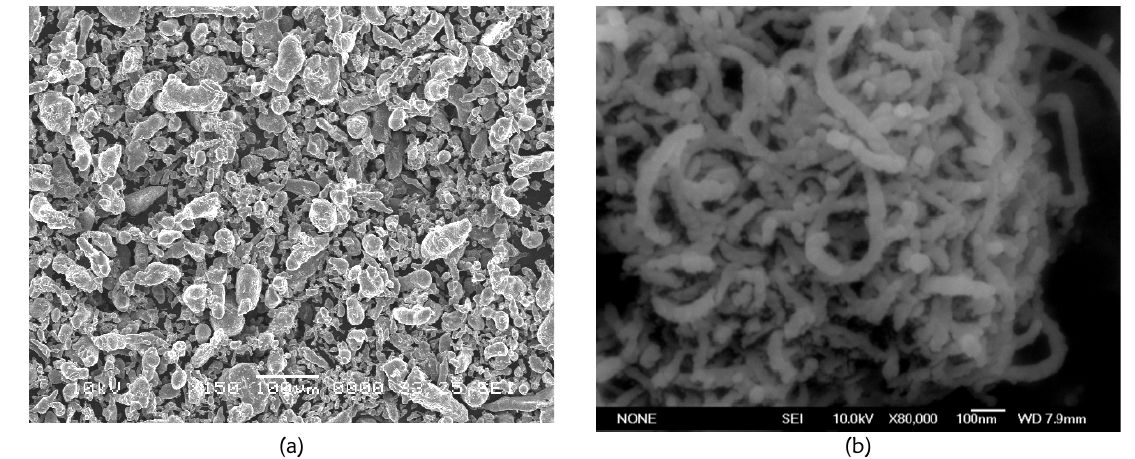
Figure1: Photo-micrograph of (a) aluminium powder and (b) CNT